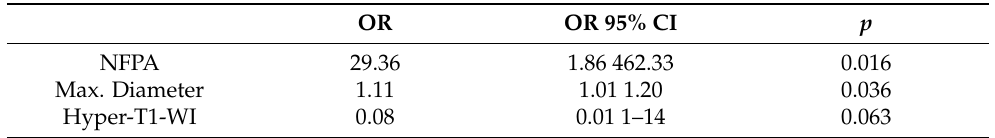
Figure 5. Roc curve showing the ability of the model to predict surgery in acute apoplexy group. Table 4. Multivariable analysis to predict surgery.